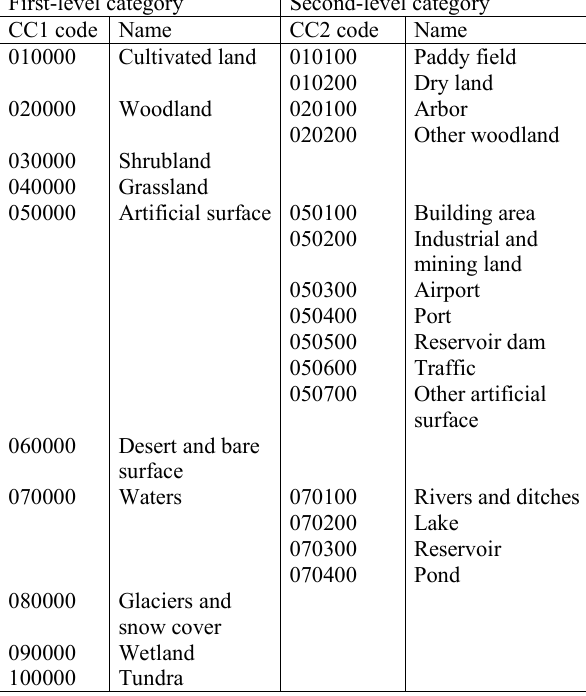
Table 2 . GLC 10 data classification system.